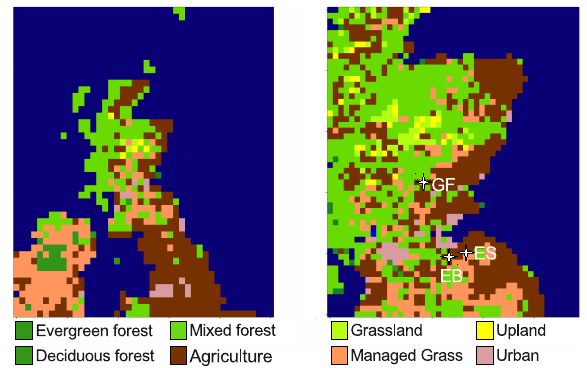
Fig. 1. Land classification map covering the spatial extent of the